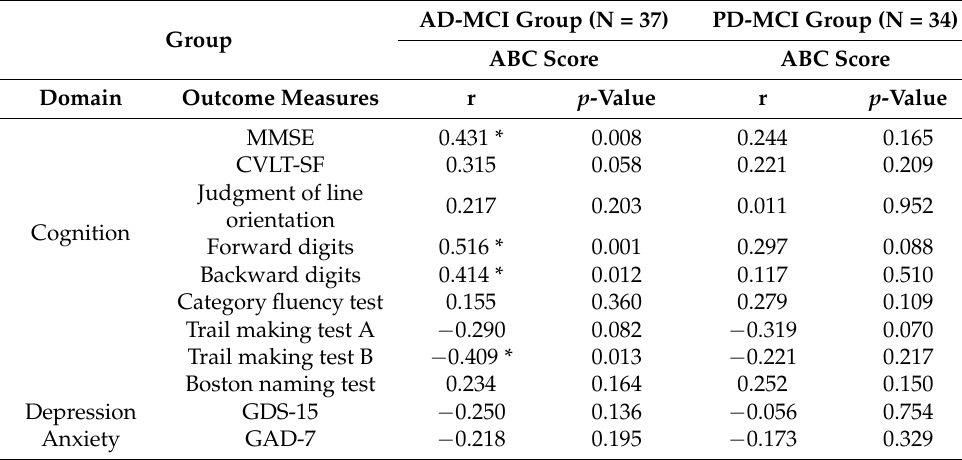
Table 2. Correlation coefficients between cognitive performance and ABC